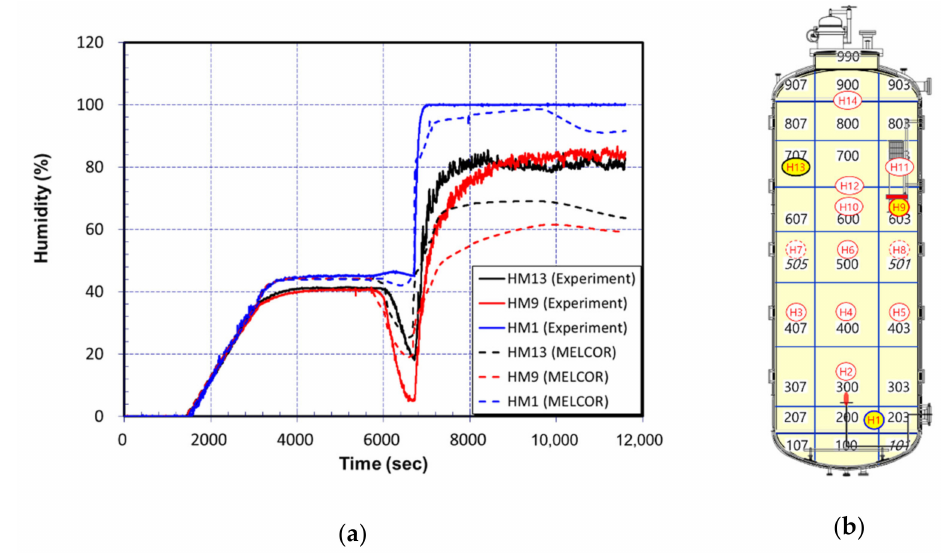
Figure 13. Comparison of MELCOR predictions with measurement data for SSP1 test: ( a ) Relative humidity; ( b ) Measurement